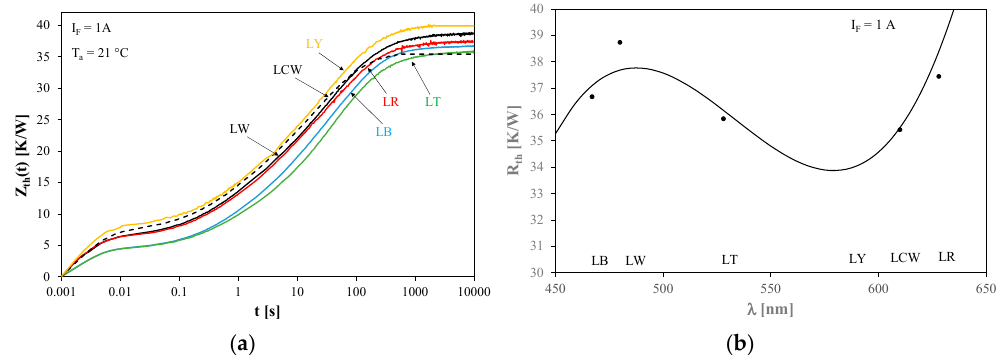
Figure 8. Measured waveforms of Z th (t) of the tested LEDs ( a ) and the dependence of thermal resistance on the central wavelength λ of the spectrum of the emitted radiation ( b ).